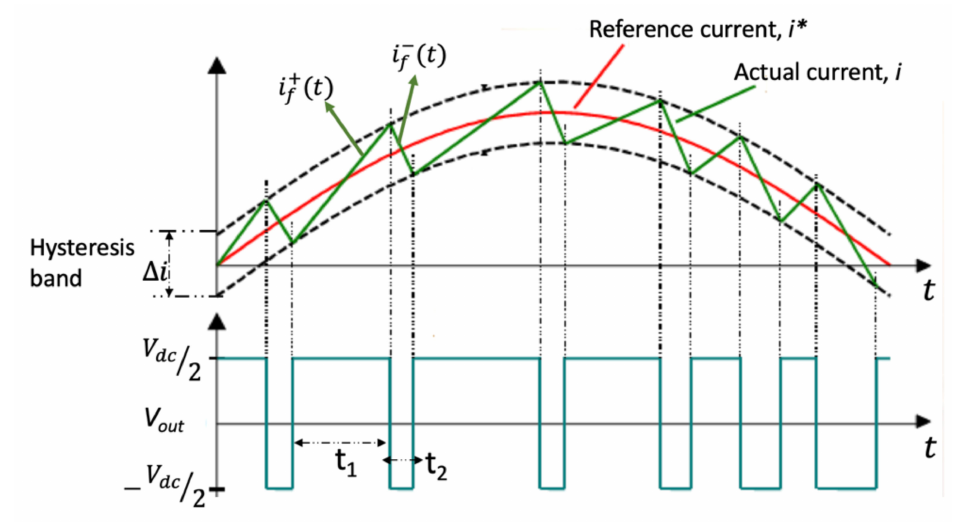
Figure 6. Hysteresis current loop